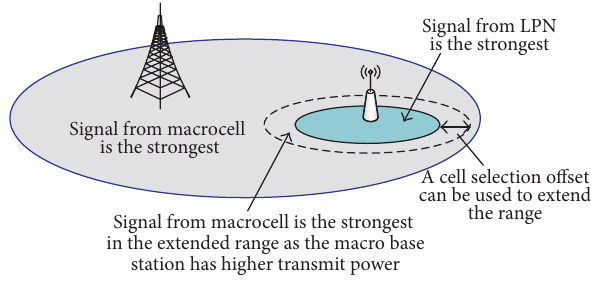
Figure 1: Illustration of cell range